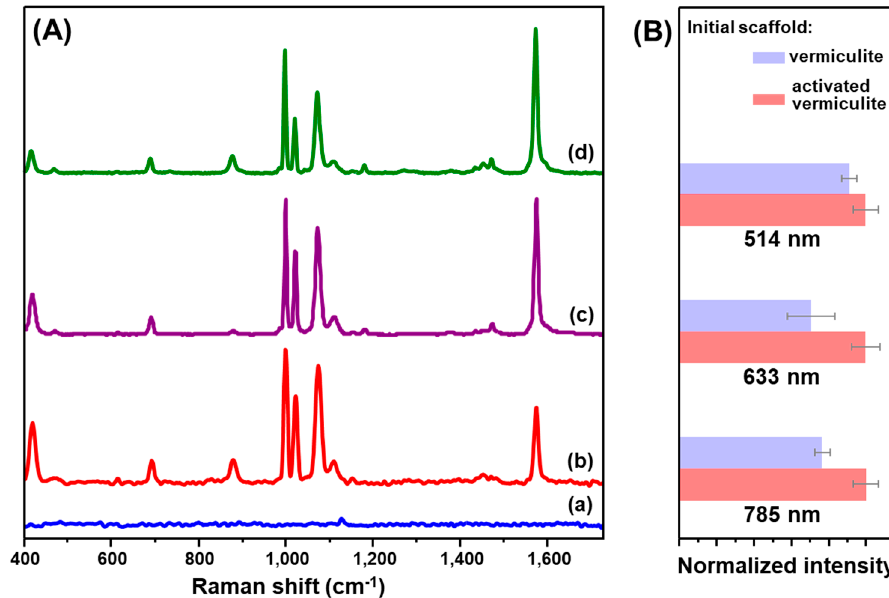
Figure 4. ( A ) Surface-enhanced Raman spectroscopy (SERS) spectra of (a) hybrid Ag microstructures from AVe and (b, c, d) benzenethiol (BT) on hybrid Ag microstructures from AVe by exciting with (b) 785 nm, (c) 633 nm, and (d) 514 nm lasers. ( B ) Normalized SERS intensity of the BT 999 cm − 1 band (peak height) for hybrid Ag microstructures from Ve and AVe at different excitation wavelengths (error bars for N = 3). SERS spectra were collected using a lens for macrosampling.